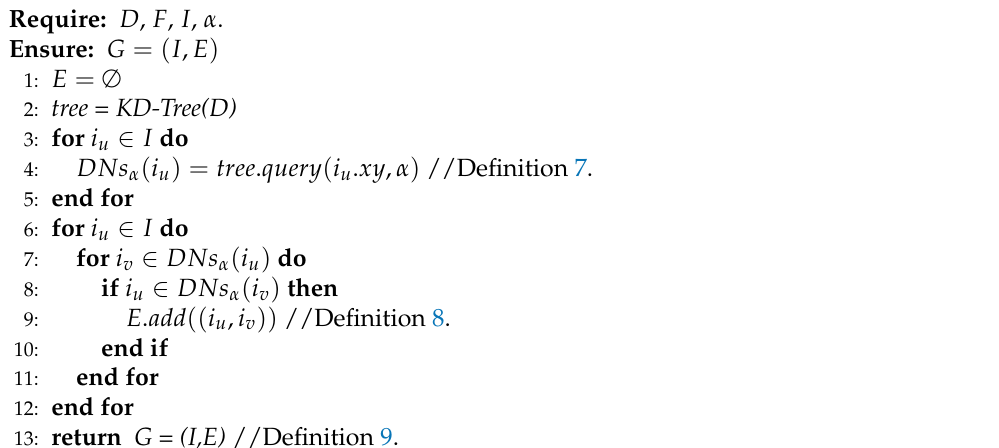
Algorithm 1 Generating mutual neighbor relationship graph on